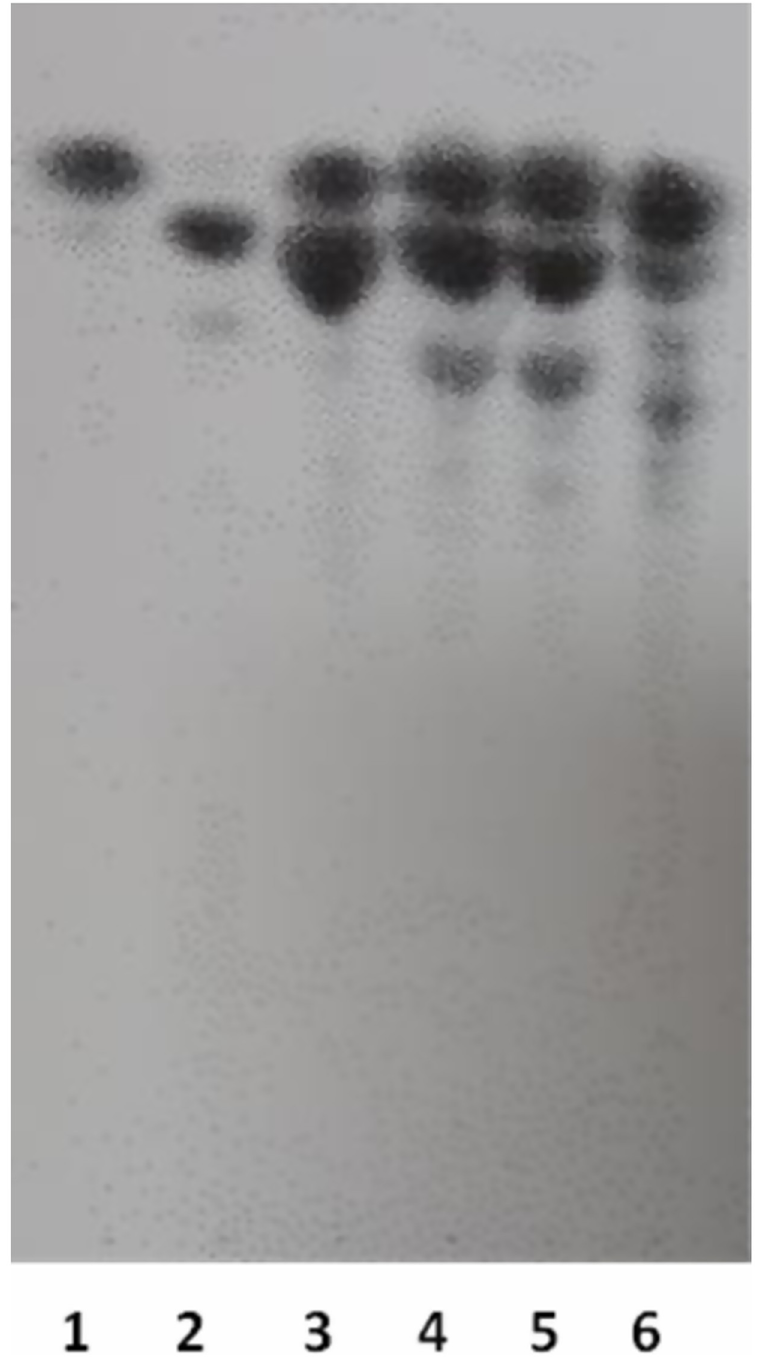
Fig 5. Thin-layer chromatography (TLC) of hydrolysis products using 1% (w/ v) of Copernicia alba seed and birchwood xylan substrate upon reaction with endo-xylanase from A. japonicus. Line 1: xylose 1 mg/mL; Line 2: xylobiose 1 mg/mL, Lines 3–4: hydrolysis products using xylanase after 30 and 60 min of incubation, using Copernicia alba seed, Lines 5–6: hydrolysis products using xylanase after 30 and 60 min of incubation, using birchwood xylan.